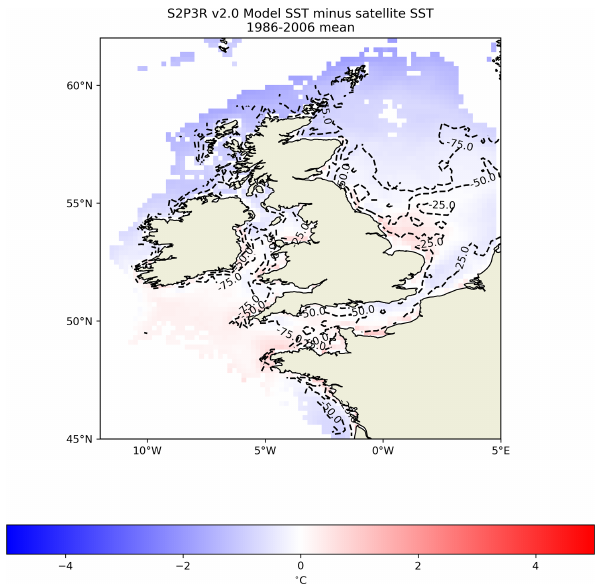
Figure 10. S2P3R v2.0 SST averaged between the years 1986 and 2006 inclusive minus satellite SSTs (Merchant et al., 2019) averaged over the same interval. Labelled dashed lines illustrate bathymetry in